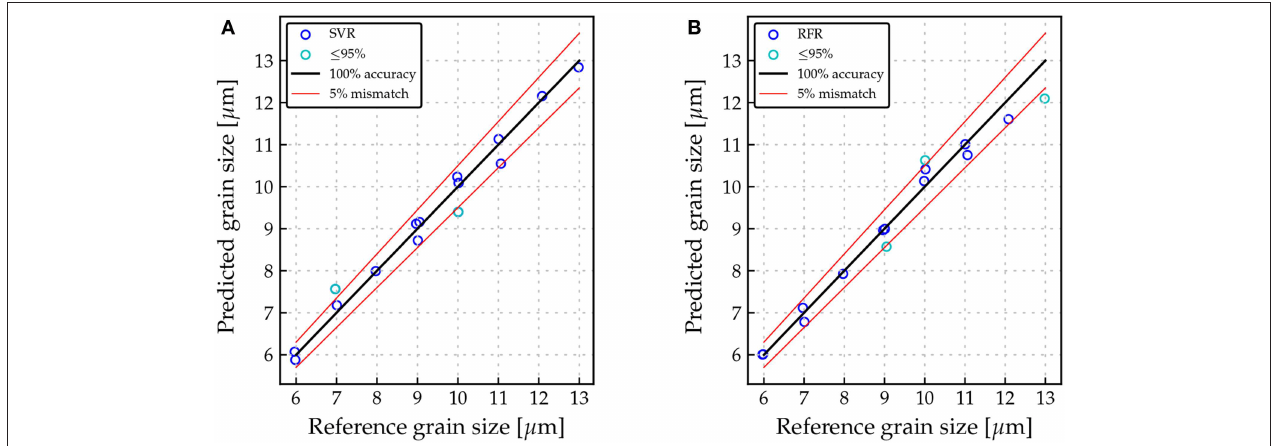
FIGURE 11 | ML results of the test data set (20 % of the data) with predicted grain size vs. reference grain size and a (B) RFR.